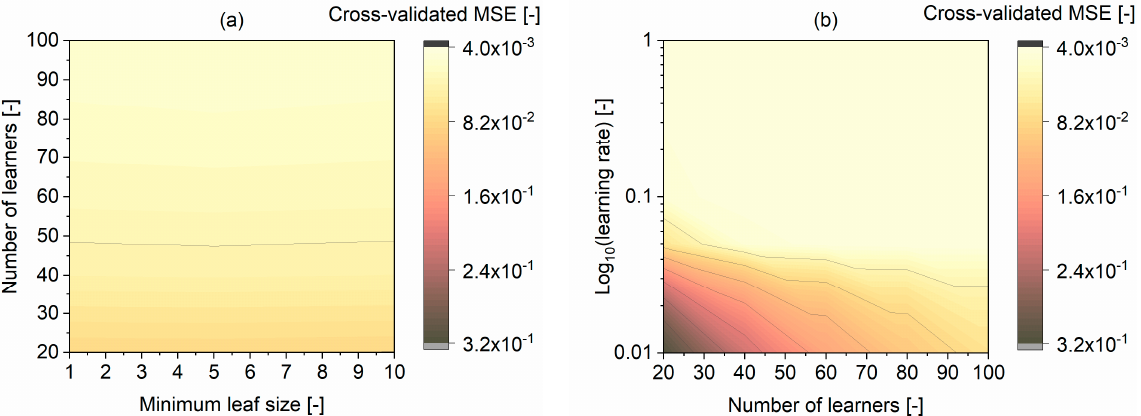
Figure 6. Hyperparameters’ effect on the ET model with the LSBoost algorithm MSE for the training and validation dataset: ( a ) minimum leaf size vs. number of learners, ( b ) number of learners vs. log of the learning rate.